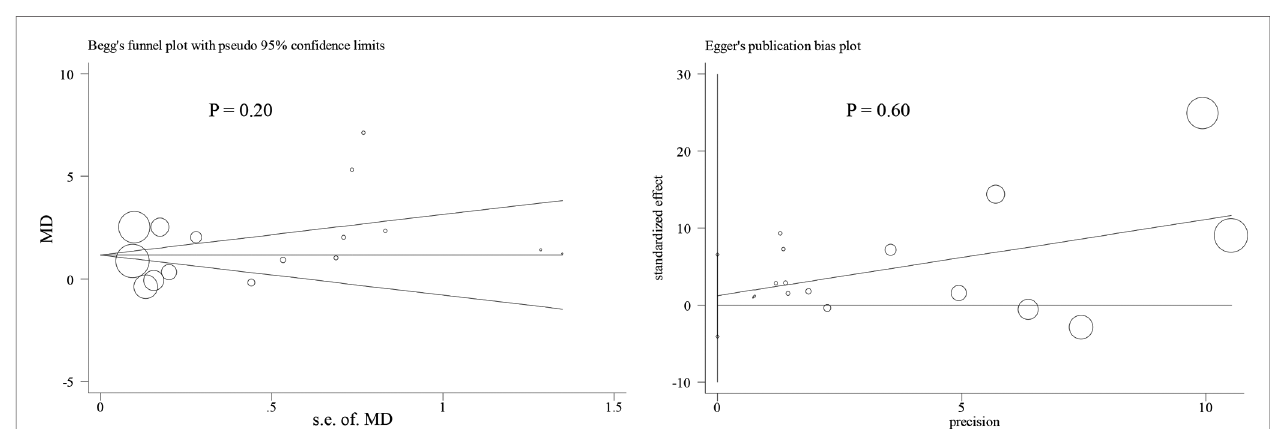
FIGURE 6 | Publication bias across included studies ( left , Begg ’ s test; right , Egger ’ s